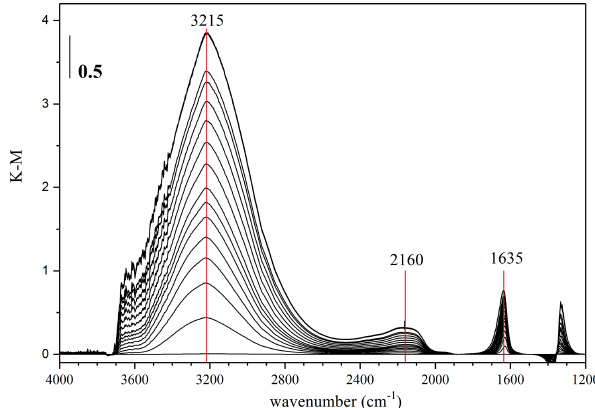
Figure 13. IR spectra of adsorbed water on SiO 2 at 30 ◦ C, as mea- sured using DRIFTS at different RH. Reprint (with modification) with permission by Ma et al. (2010a). Copyright 2011